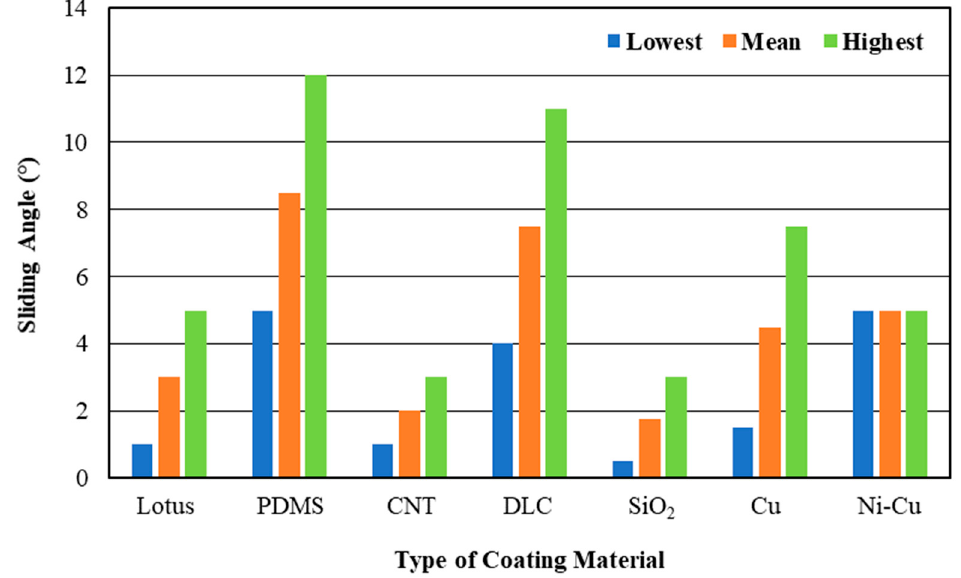
Figure 5. An analysis of the recorded sliding angles for some coating materials. Any sliding angle <5° is considered on a par with that of the lotus